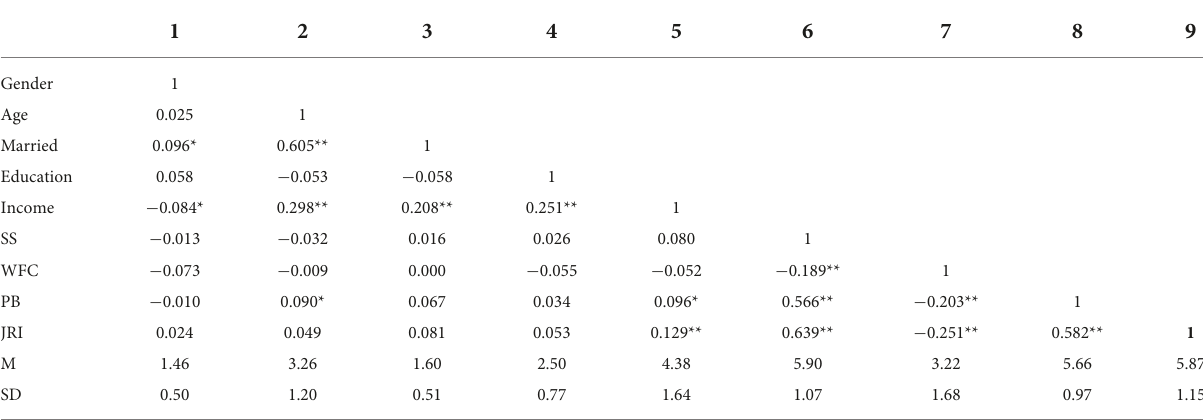
TABLE 3 Descriptive statistics and correlation coefficients of the